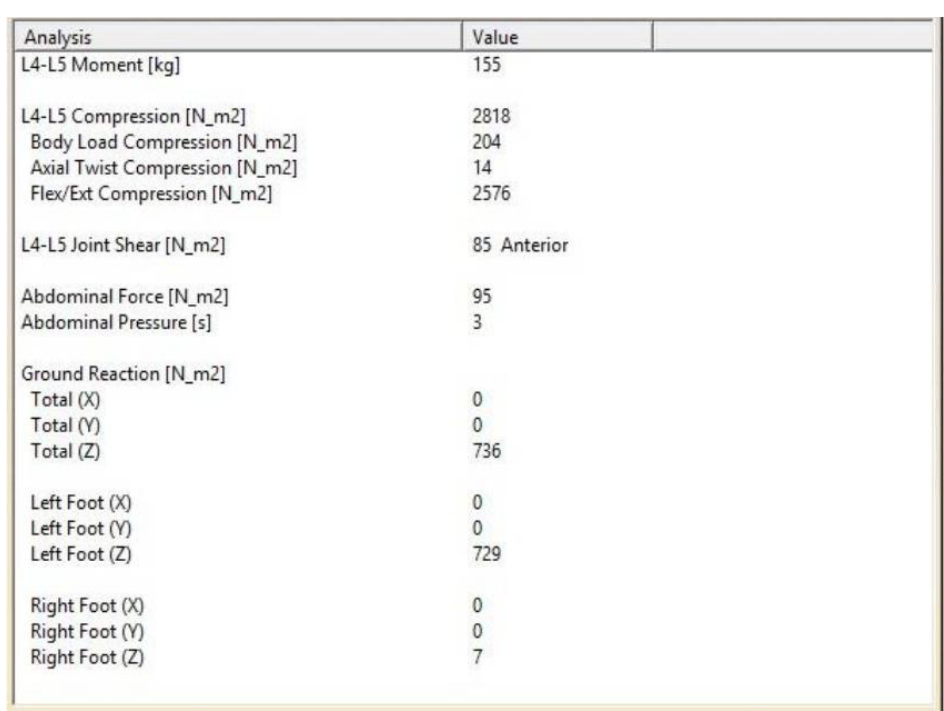
Figure 3. Summary of the biomechnical analysis the typical body